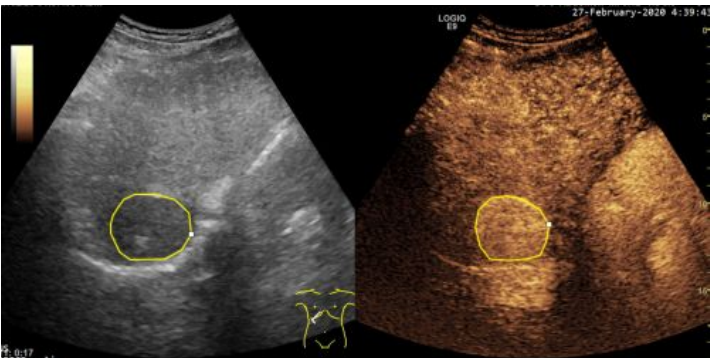
Figure 1. Example of a Hepatocellular Carcinoma (HCC) tumor within B-mode Ultrasound ( left ) and Contrast-Enhanced Ultrasound (CEUS) images ( right ), delineated by an experienced